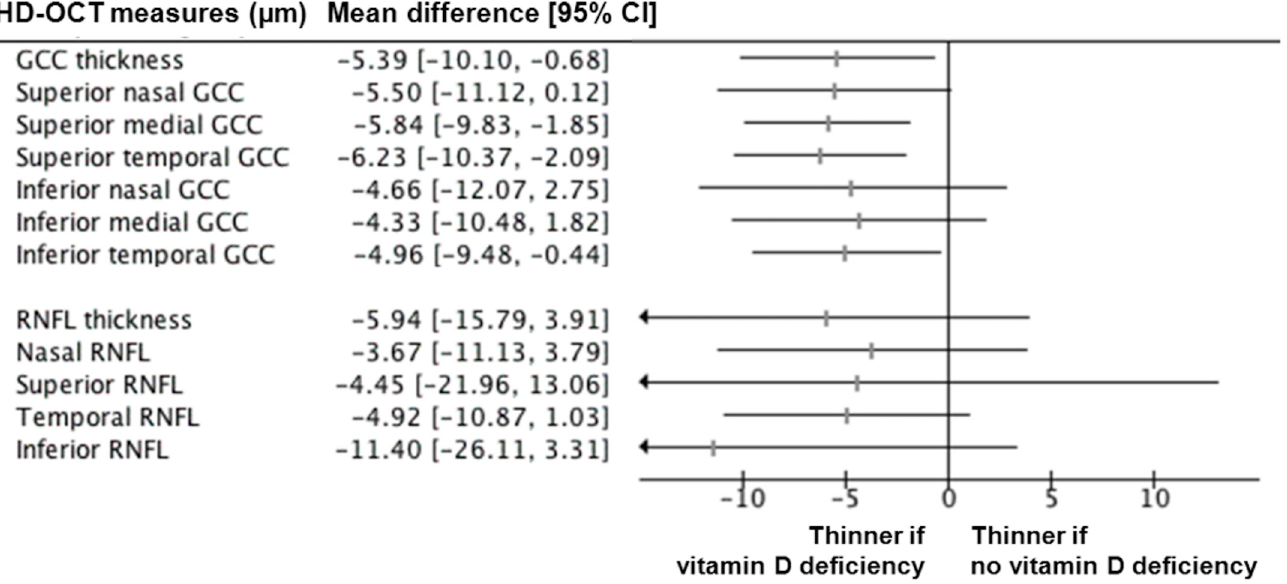
Fig 1. Forest plot for the mean difference of ganglion cell complex (GCC) and retinal nerve fibre layer (RNFL) thickness according to vitamin D deficiency (i.e., serum 25-hydroxyvitamin D (cid:1) 25 nmol/L). Horizontal lines correspond to the 95% confidence interval (CI). The vertical line corresponds to a mean difference of 0.00, equivalent to no between-group difference.